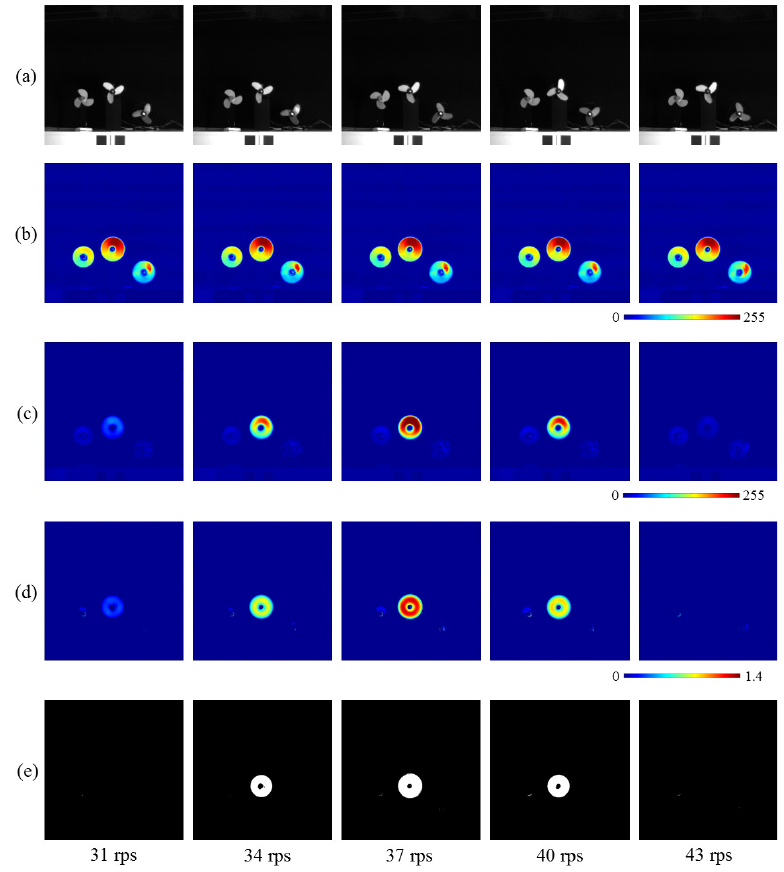
Figure 12. ( a ) Input images; amplitude of ( b ) input; and ( c ) pixel-wise filtered images; ( d ) amplitude ratios; ( e ) extracted vibration